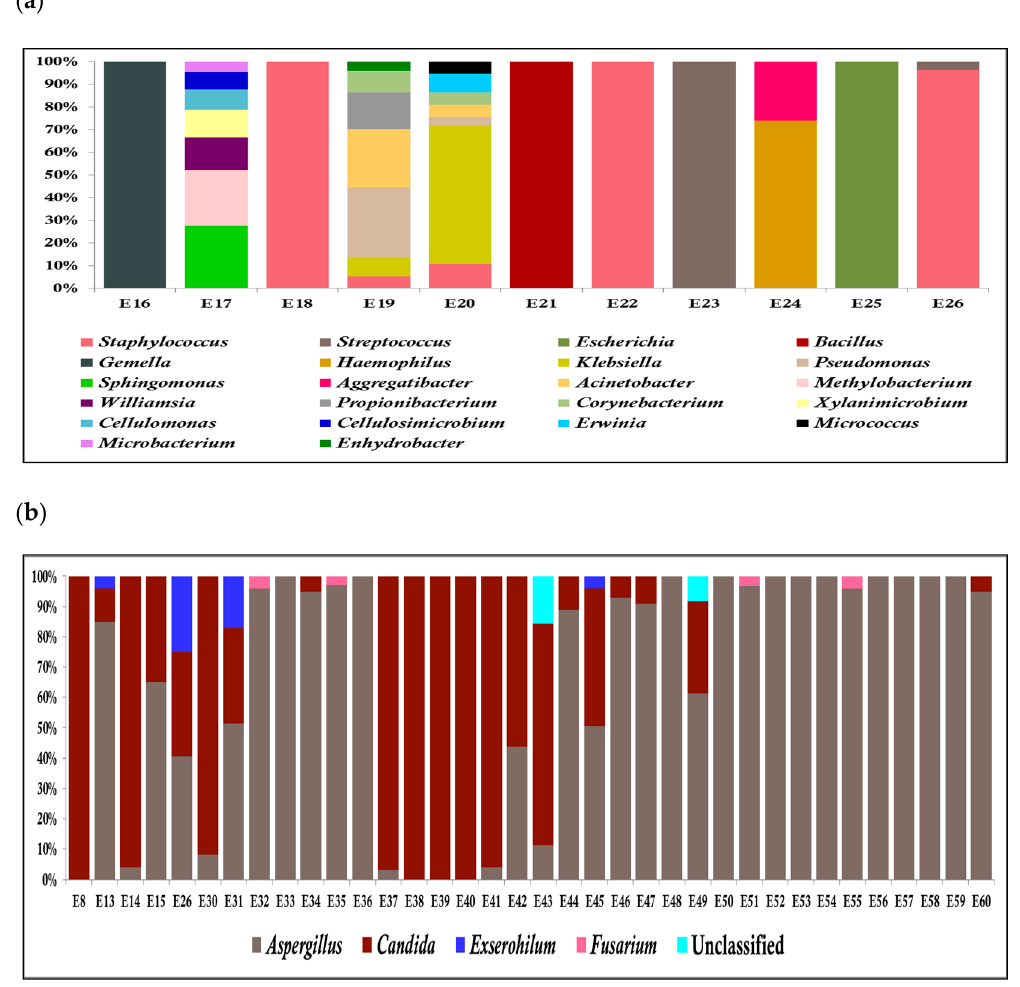
Figure 1. Stacked bar graph for culture-negative samples by HTS. ( a ) Stacked bar graph displaying the relative abundances of the bacterial genera obtained by HTS of culture-negative vitreous samples.